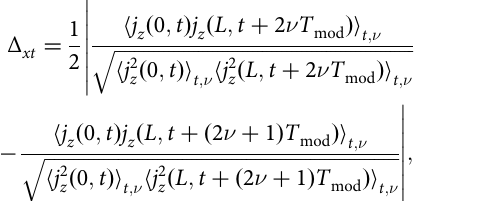
¼ 140 GHz and gives the space − time trace j z ( x , t ) at f mod ¼ 0 : 1. Figure 3c gives its spatiotemporal Fourier transform A mod in terms of the amplitude ∣ j z ( β , f ) ∣ , where β is the wavenumber (reciprocal of wavelength) along x . It shows a strong peak at the = 2 and a wavenumber corre- half-harmonic frequency f mod sponding to mode index l = 9. This is manifested by the line projection of the Fourier amplitude across the half-harmonic peak versus frequency in Fig. 3b and versus wavenumber in Fig. 3d, respectively. We then de fi ne a spatiotemporal correlation function,